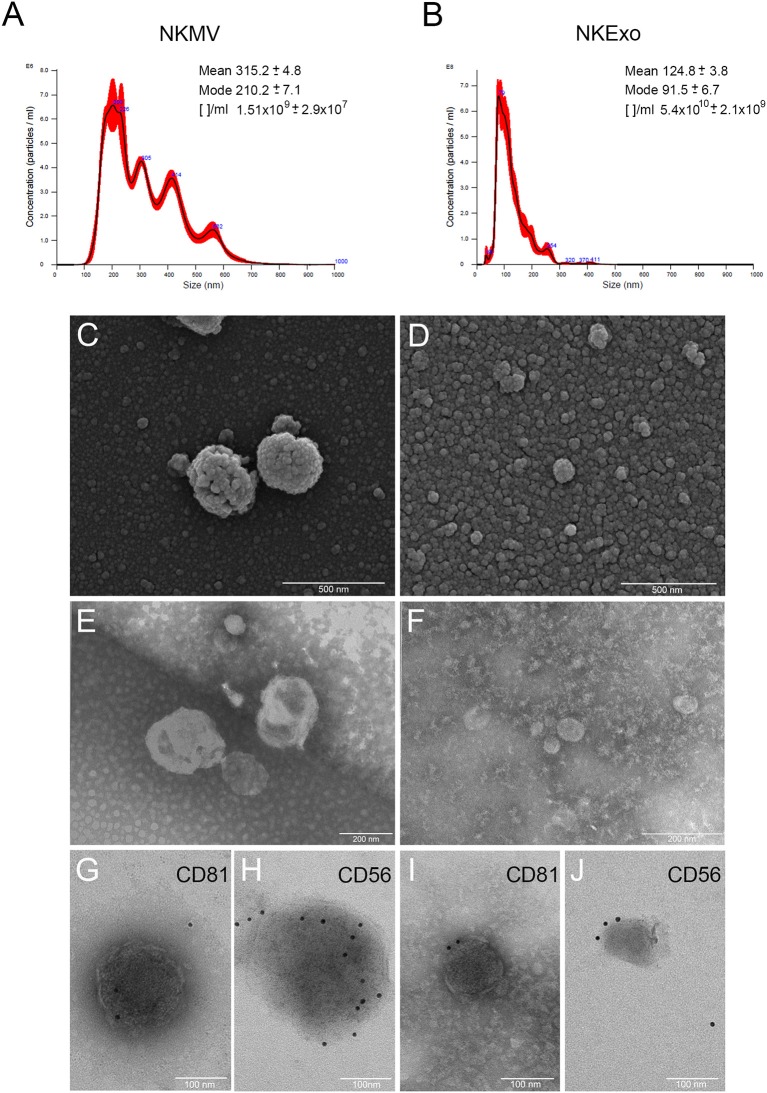
Morphological characterization of natural killer cell-derived extracellular vesicles (NKEVs). (A,B) Nanoparticle tracking analysis (NTA) analysis of NK-cell-derived microvesicle (NKMV) and NKExo. Representative spectra are shown, and mean, mode, and particles number/ml ([]/ml) are reported. (C,D) Scanning electron microscopy analysis of NKMV (C) and NKExo (D). Bars, 500 nm. (E,F) Transmission electron microscopy analysis of NKMV (E) and NKExo (F). Bars, 200 nm. (G–J) Immunoelectron microscopy combined with positive/negative contrast method of NKMV (G,H) and NKExo (I,J) revealed the presence of CD81 (G,I) and CD56 (H,J). Bars, 100 nm.